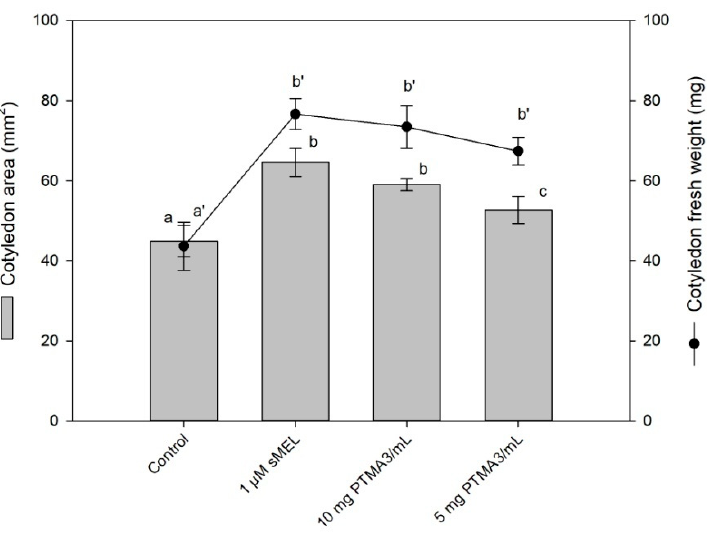
Figure 5. Effect of synthetic melatonin (sMEL) and PTMA3 on etiolated lupin cotyledon area and fresh weight after 48 h of incubation. Control (only buffer media). Data represent the mean values for each treatment. Error bars represent standard errors of the mean of four replicate experiments (n = 4). Different superscript letters indicate statistically significant differences at p < 0.05.